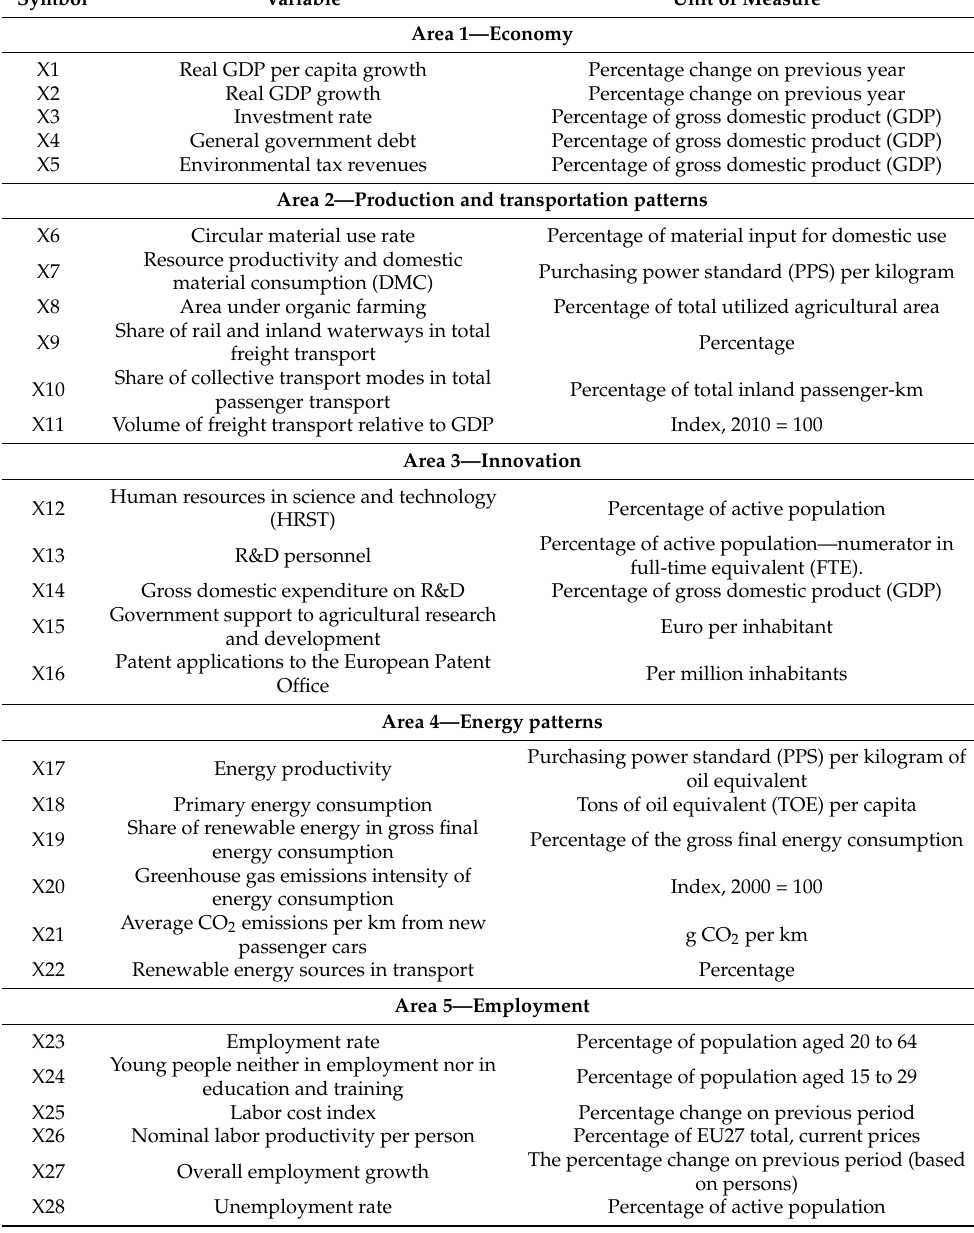
Stage 4: Normalization of indicators. Two methods of normalization of indicators were used: standardization (Hellwig’s method) and zero unitization (TOPSIS method)